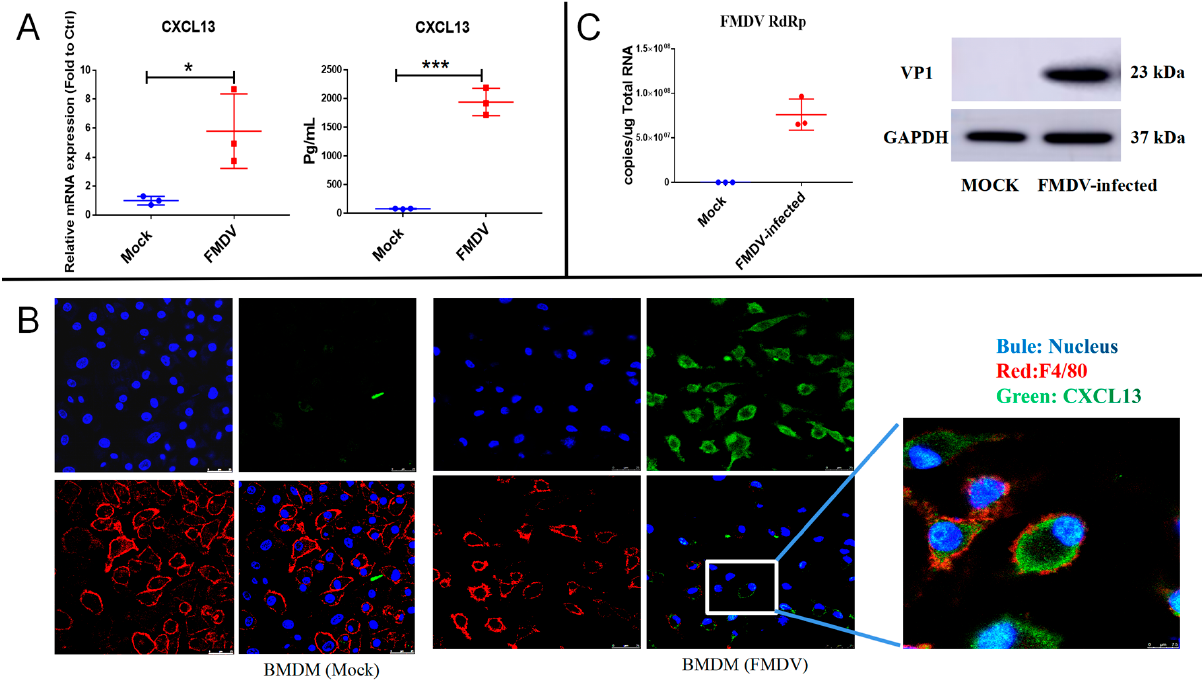
Figure 2. CXCL13 was produced in BMDMs after FMDV infection. ( A ) The mRNA expressions and the protein levels of CXCL13 in uninfected BMDMs (Mock) and FMDV-infected BMDMs at 24 hpi were quantified by RT-qPCR and ELISA, respectively. ( B ) CXCL13 (green), F4/80 (red), and nucleus (blue) were co-stained in Mock and FMDV-infected BMDMs at 24 hpi. ( C ) The FMDV RdRp sequence and FMDV VP1 protein were detected in Mock and FMDV-infected BMDMs at 24 hpi with RT-qPCR and Western blotting, respectively. Upper panels, original magnification × 100 (scale bar = 25 µ m). The white box indicated the regions at higher magnifications (scale bar = 7.5 µ m). At least 10 fields of immunofluorescence were observed. Significance was detected using unpaired t test. *, p ≤ 0.05; ***, p ≤ 0.001.